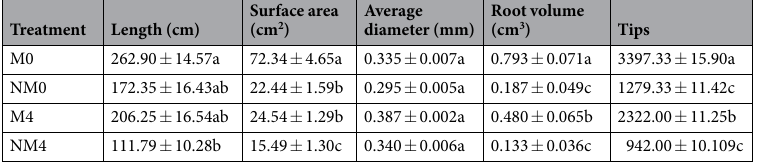
Table 2. Morphological traits of roots of seedlings of Neva irrigated with magnetized and non-magnetized brackish water for 30 days. Data in the table are the means ± SEs of at least three replicates. Values followed by different lowercase letters indicate significant differences at the 0.05 probability level.